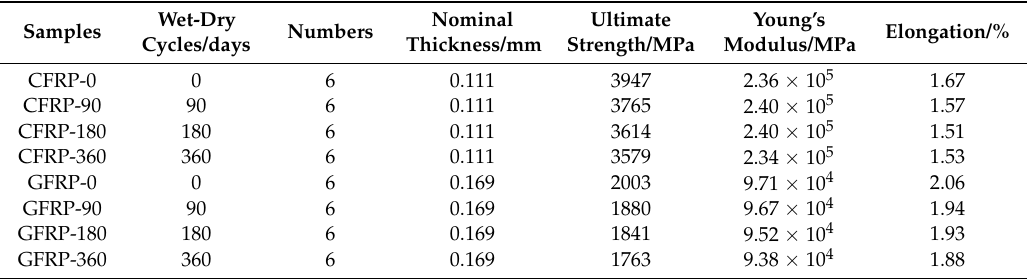
Table 1. The properties of FRP under different wet-dry cycling